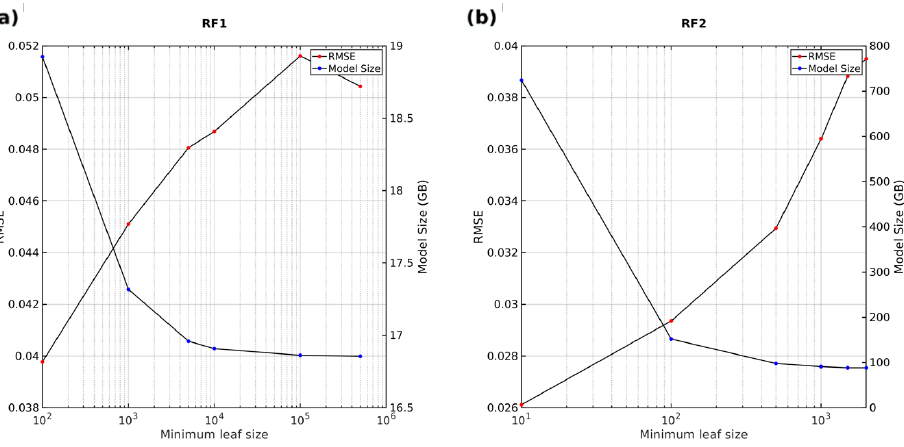
Figure 3. ( a ) Model performance for RF1, ( b ) RF2 (right) for different MLS values. Right-side axis indicates model file size; for RF2 this value corresponds to the sum of all